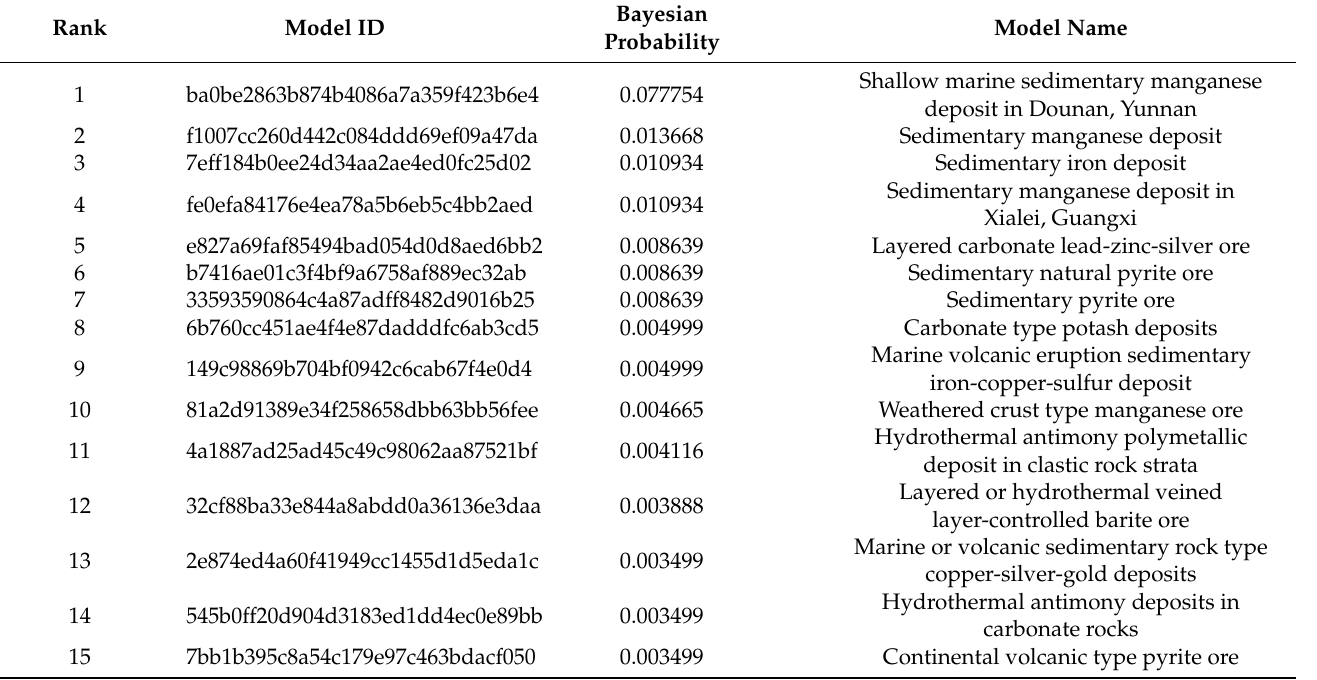
Table 6. List of the top 15 prospecting models in Bayesian probability